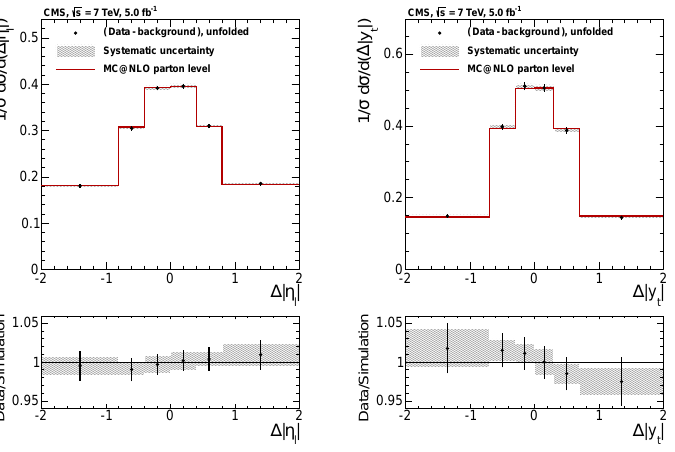
Figure 4. Background-subtracted and unfolded differential measurements of ∆ | η | ( left ) and ∆ | y | ( right ), both normalised to unit area (points), and the parton-level predictions from MC @ NLO (his- tograms). Bottom: the ratio between the data and the MC @ NLO prediction for lepton ∆ | η | ( left ) and t ¯ t ∆ | y | ( right ). The error bars represent the statistical uncertainties in the data, while the systematic uncertainties are represented by the hatched band. The first and last bins include underflow and overflow events, respectively [24].